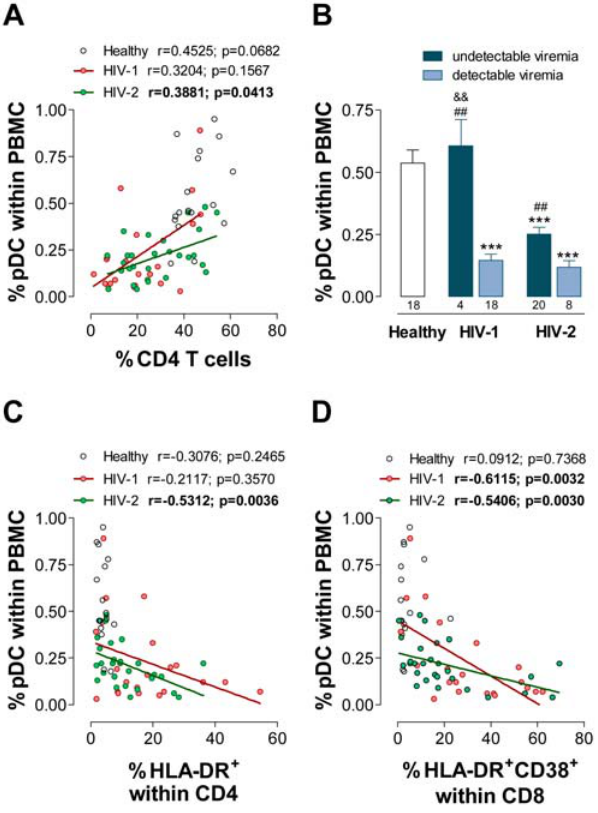
Figure 2. Relationship of pDC levels with CD4 T cell, T cell activation and viremia. Correlation between percentage of pDC within PBMC and percentage of CD4 T cells ( A ), percentage of HLA-DR within CD4 T cells ( C ), as well as percentage of HLA-DR + CD38 + within CD8 T cells ( D ), in HIV-2 and HIV-1 infections. Comparison of the pDC frequencies in the infected cohorts divided into viremic and ‘‘aviremic’’ (below test cut-off) groups ( B ). Bars represent mean 6 SEM. Numbers under the bars represent the total individuals analyzed. *** p , 0.001 as compared to controls. ## p , 0.01 between ‘‘aviremic’’ and viremic patients of the same cohort. && p , 0.01 between HIV-1 and HIV-2 ‘‘aviremic’’ patients.